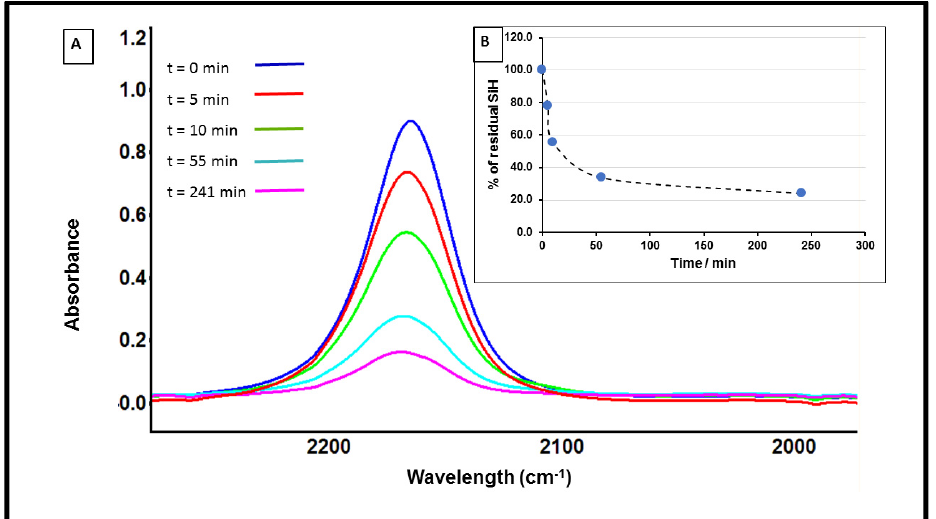
Figure 1. ( A )—IR spectra of SiH band taken during reaction of 20 wt% PHMS solution in toluene at 30 °C in the presence of 1 × 10 − 2 mol/L of B(C 6 F 5 ) 3 . ( B )—SiH conversion vs. time dependence of the 20 wt% PHMS restructuration at the same conditions.